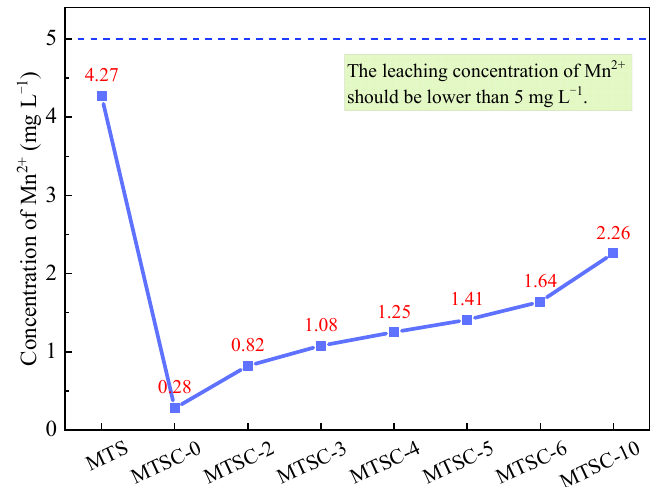
Figure 13. Leaching concentration of Mn 2+ in MTS and MTSC.